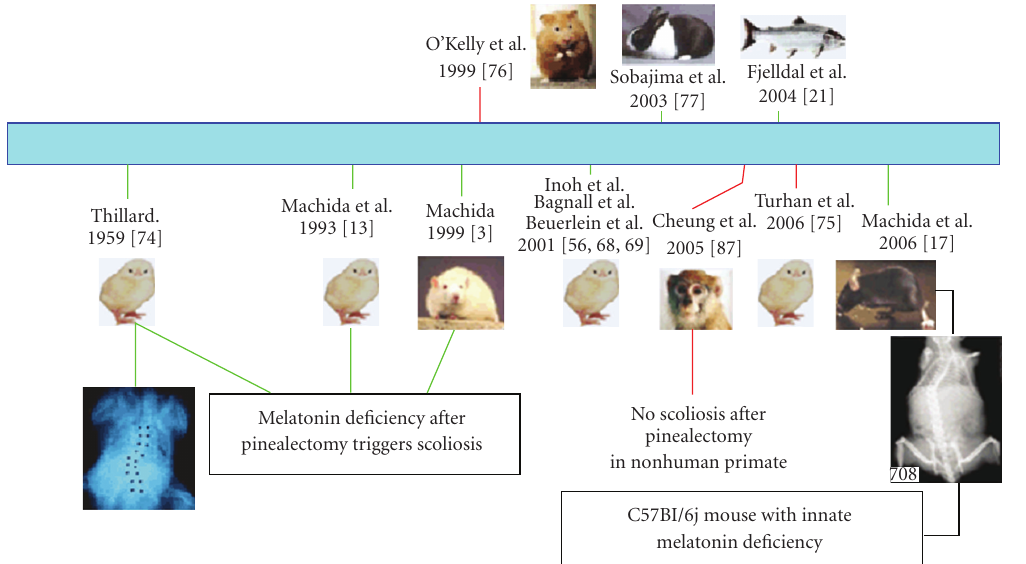
Figure 2: Summary of the experiments focused on the hypothesis involving a melatonin deficiency as the source for AIS. E ff ective (green lines) and none ff ective (red lines) results are indicated. Modified from Moreau et al.